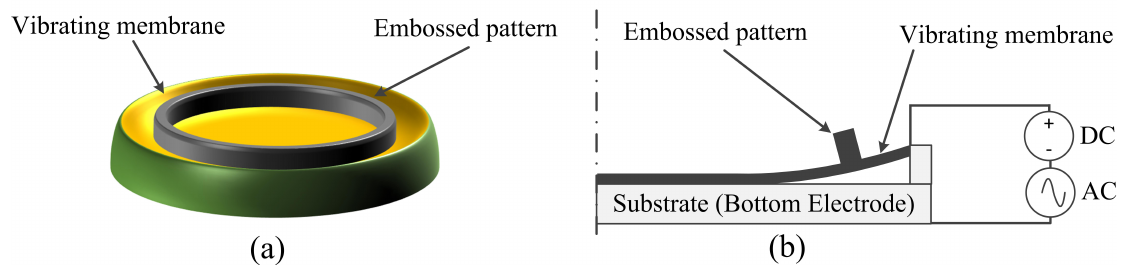
Figure 1. ( a ) Overview of an embossed Capacitive Micromachined Ultrasonic Transducer (CMUT) cell; ( b ) two-dimensional axisymmetric cross sectional view of an embossed CMUT cell in collapse